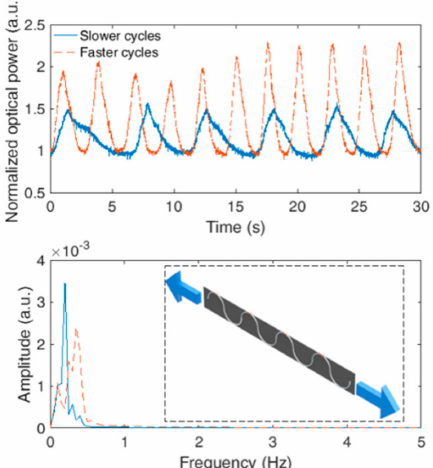
Figure 5. Characterization of the POF-embedded smart textile for respiratory rate monitoring. Figure inset shows a schematic representation of the characterization